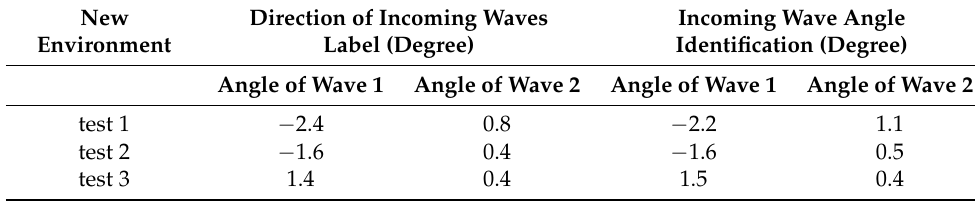
Figure 12. Error plots of the S2S network meta − reinforcement learning algorithm based on two perspectives in the original environment, respectively ( a , b ). ( a ) Error plot of the S2S network meta − reinforcement learning algorithm based on the first angle in the new environment. ( b ) Error plot of the S2S network meta − reinforcement learning algorithm based on the second angle in the new environment. Table 3. Identification results of coherent DOA in the new environment.